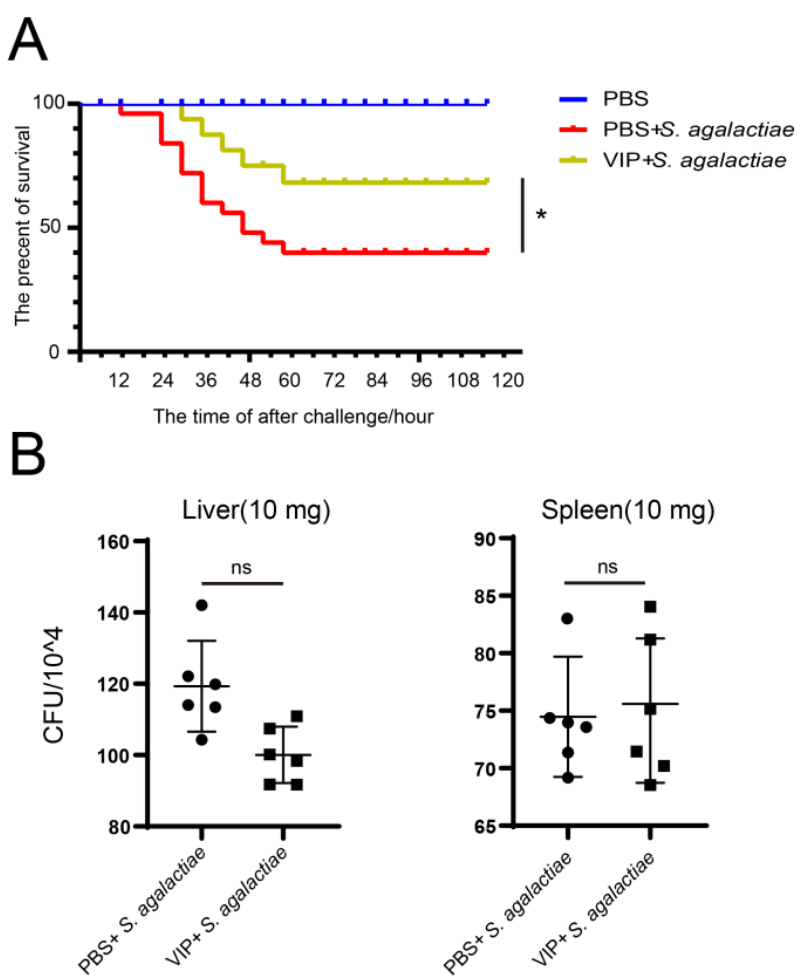
Figure 7. ( A ) After S. agalactiae infection, the survival rates of Nile tilapia. The PBS-treated Nile tilapia for control, deaths were counted every 6 h for a total of 120 h, n = 100 for each group. Each fish in the PBS group, PBS + S. agalactiae group, and On-VIP + S. agalactiae group was injected with 100 µ L PBS, S. agalactiae , and mixture of S. agalactiae and On-VIP peptide, respectively. Asterisks indicate a significant difference ( p < 0.05). ( B ) At 24 h after S. agalactiae infection, the bacterial loads of the liver and spleen were detected. Every value is presented as the mean and standard deviation; n = 6; ns is used to indicate no significant difference ( p > 0.05).